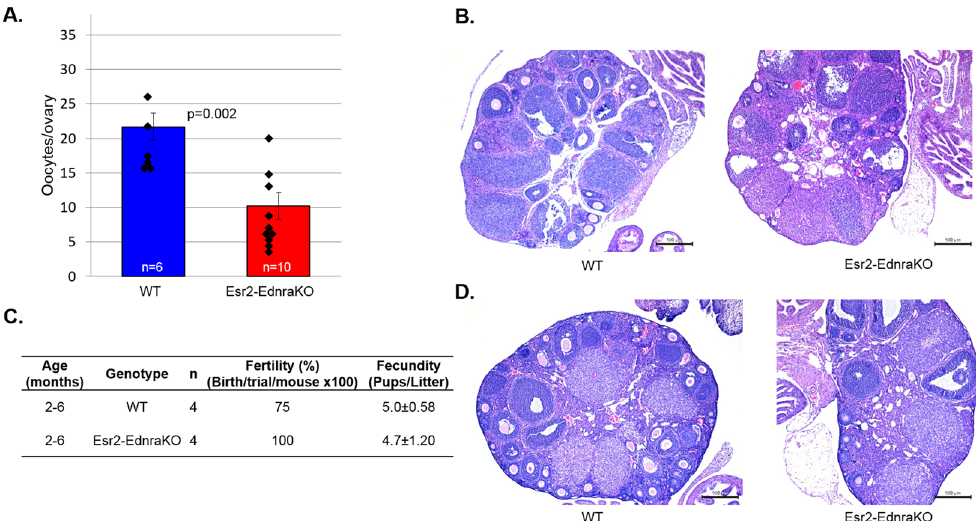
Figure 5. Ablation of Ednra in granulosa cells reduces ovulation. Ednra-flox mice were bred with Esr2- iCre mice to produce Esr2-EdnraKO mice. ( A ) After superovulation, oocytes were collected and counted at hCG24 hrs. Esr2-EdnraKO mice ovulated significantly fewer oocytes than WT controls, and had a greater range of oocytes ovulated. Error bars represent the SEM; diamonds indicate each data point. ( B ) Histology of representative ovaries at hCG24 hrs from each genotype, 4X. ( C ) WT and Esr2-EdnraKO female mice were bred with control proven males, one male and one female of each genotype per cage for 10 days. The percentage of females that gave births and the number of pups per litter quantified. There was no difference between groups. ( D ) Histology of representative ovaries after breeding study, 4x. Multiple corpora lutea were present in each